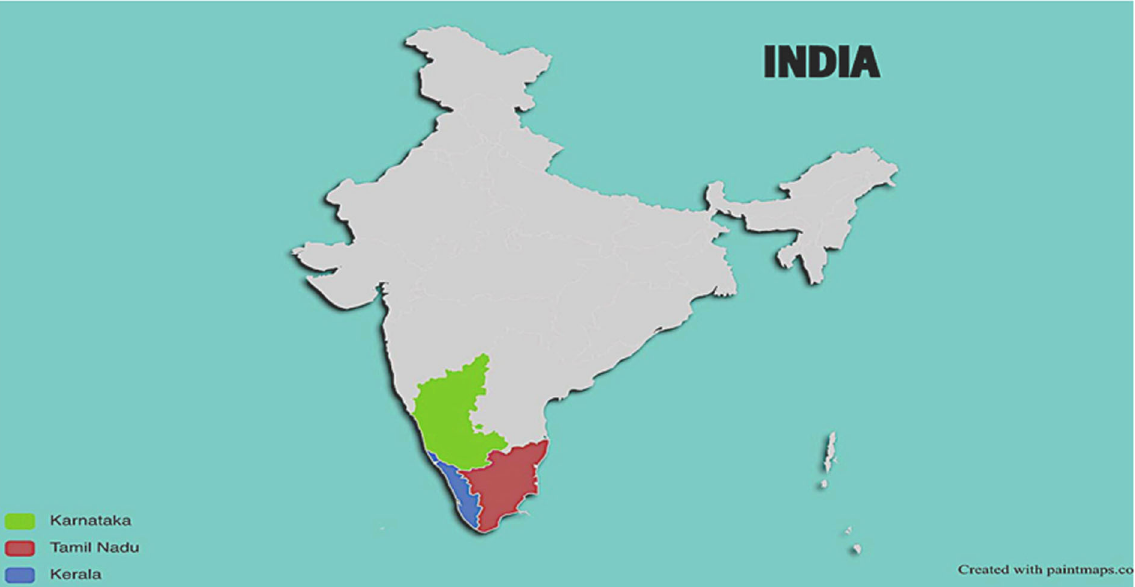
Fig. 1 Map of the study states. This map shows the three states in South India, i.e., Kerala (Blue), Tamil Nadu (Red) and Karnataka (Light green), where coconut palms grow extensively. The study excludes Andhra Pradesh as the data is unavailable due to its separation into two states during the study period. (source of the map: map of India with disputed territories created with paintmaps.com and can be used freely).